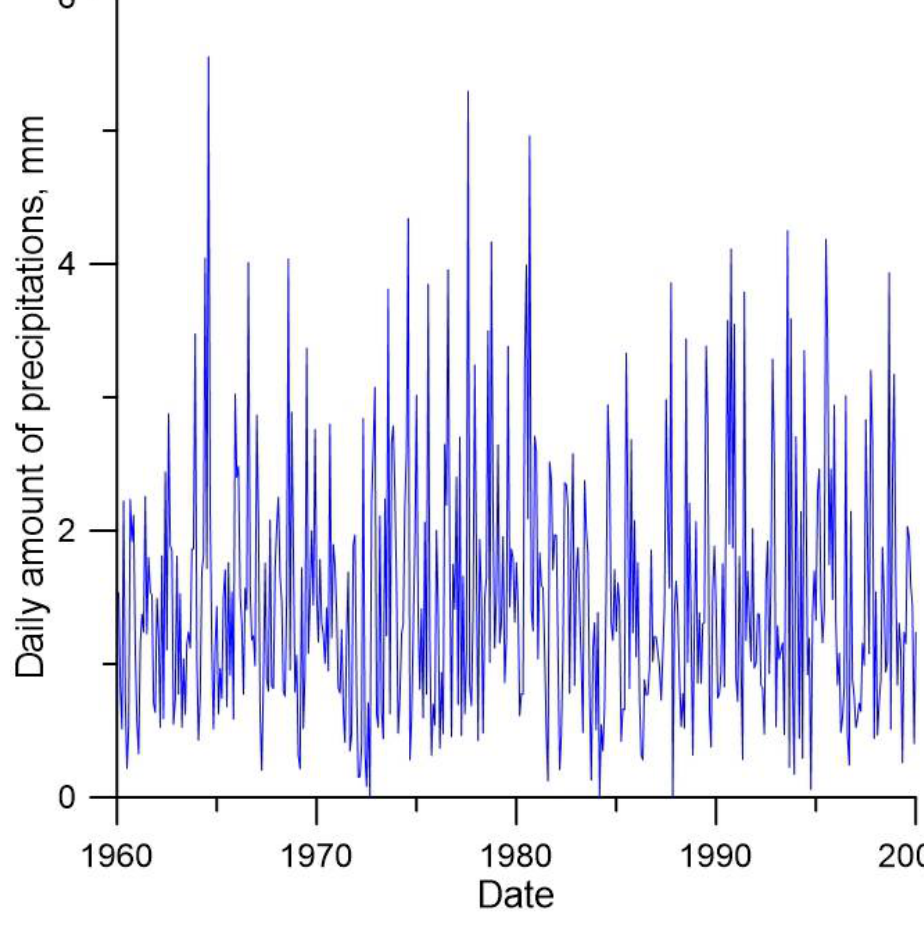
Figure 8. Atmospheric precipitations at pollution site after [13].